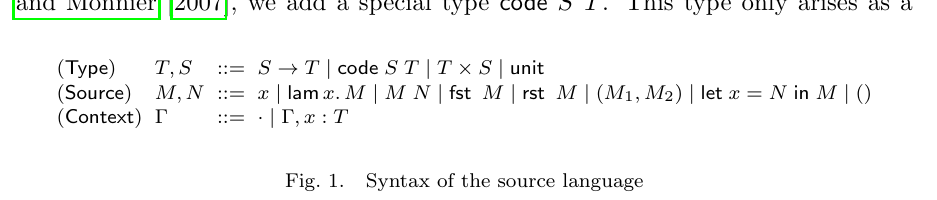
Fig. 1. Syntax of the source